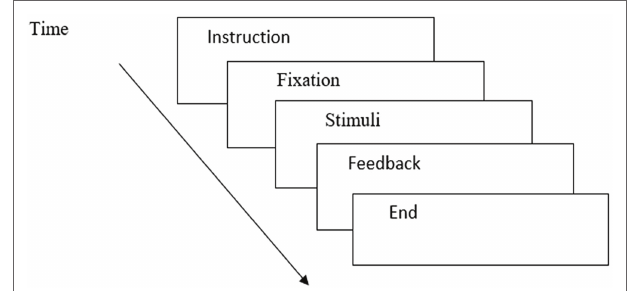
FIGURE 1 | Procedure for the processing experiment by